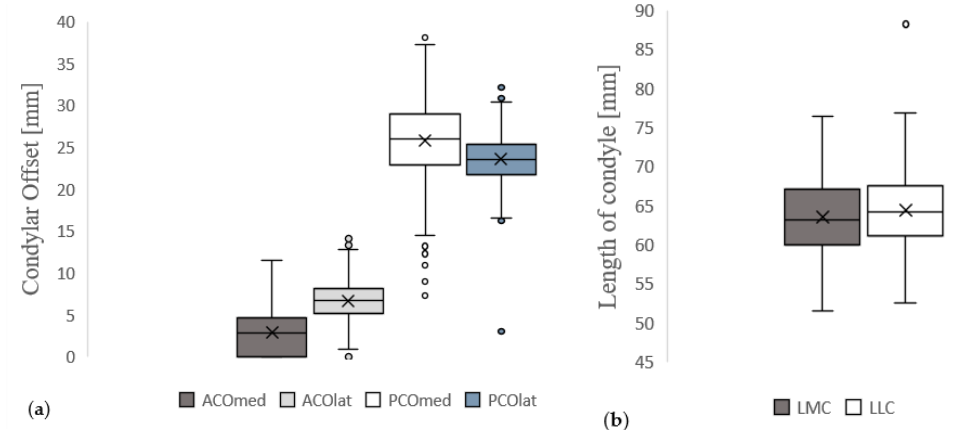
Figure 3. Descriptive analysis of femoral condylar morphology in patients without radiological structural damage or manifest osteoarthritis ( n = 409): ( a ) shows the box plots of femoral condylar offset parameters (dark grey: medial anterior condylar offset (ACO med ); light grey: lateral anterior condylar offset (ACO lat ); white: medial posterior condylar offset (PCO med ); blue: lateral posterior condylar offset (PCO lat )). ( b ) shows the box plots of the length of femoral condyles (dark grey: length of medial femoral condyle (LMC); white: length of lateral femoral condyle